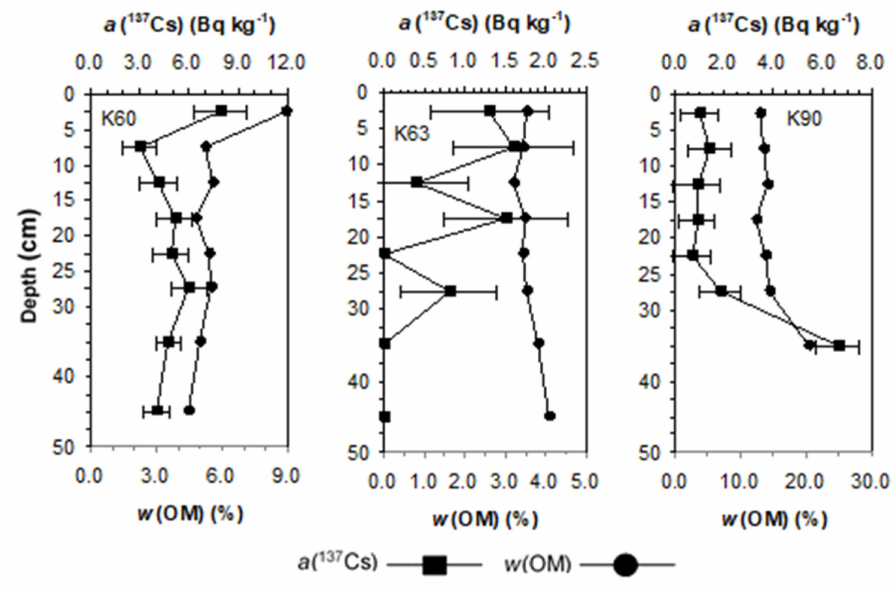
Figure 9. Disturbed 137 Cs massic activity profiles reflecting anthropogenic influence and organic matter mass fraction profiles. Measurement uncertainties are expressed with k = 2 for normal